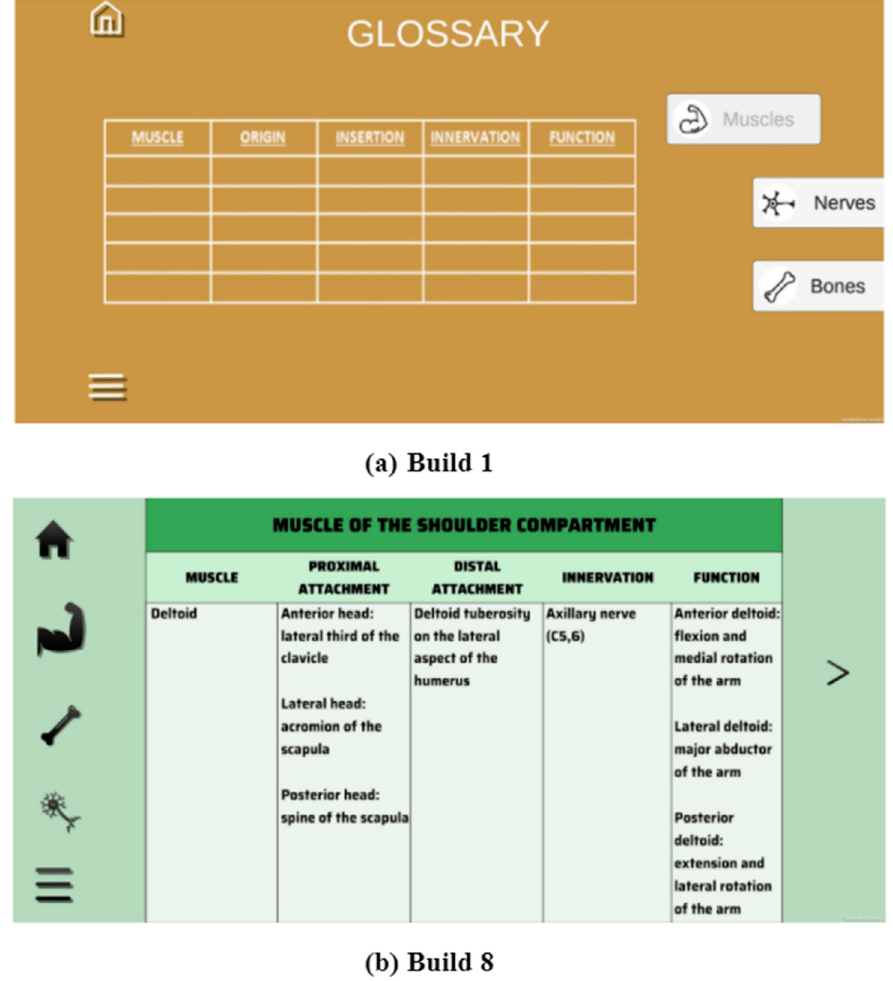
Figure 9. The changes made to the Glossary feature during application development.